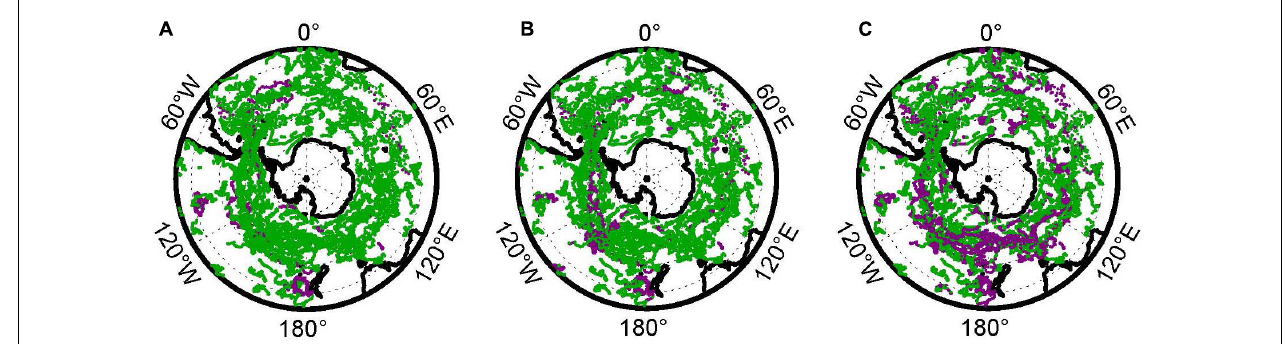
FIGURE 2 | SOCCOM float tracks colored by data quality for (A) oxygen, (B) nitrate, and (C) pH. Points along a float track marked in purple represent profiles where 100% of the data has been marked “bad” by one of the automated QC tests. All other profile locations are indicated in green.